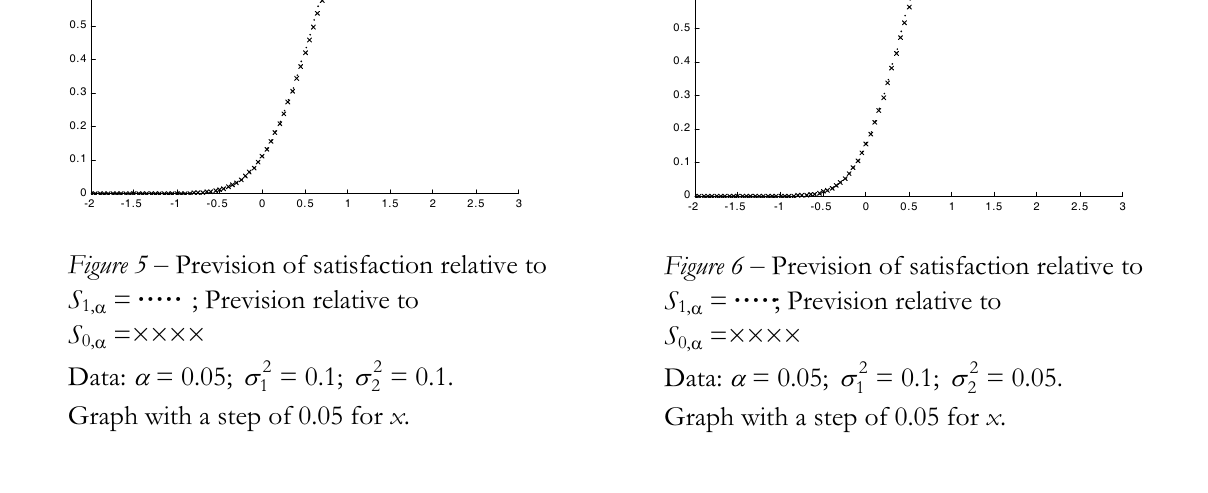
Graph with a step of 0.05 for x .